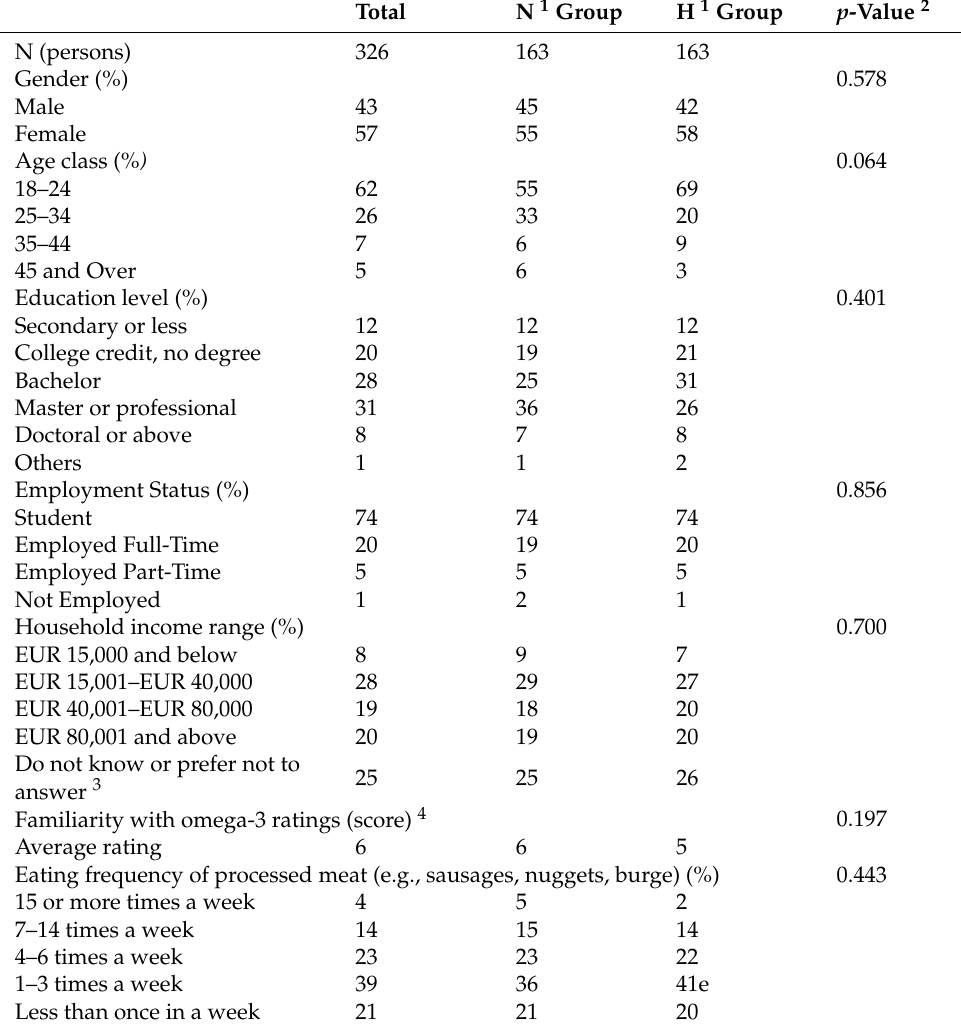
Table 2. Characteristics of the total participants, N group and H